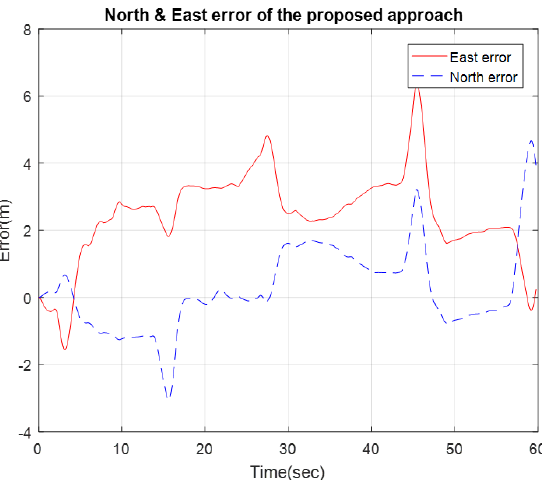
Figure 16. Errors in the north and east direction of the proposed Figure 18. Errors in the north and east direction of the proposed approach integrated with INS during 60 Secs of GNSS signal approach INS integration during 120 Secs of GNSS outage. outage.